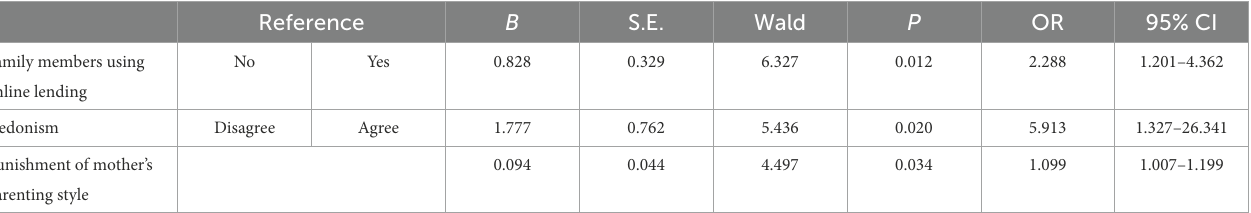
TABLE 6 The information and results of previous studies in China. Cities